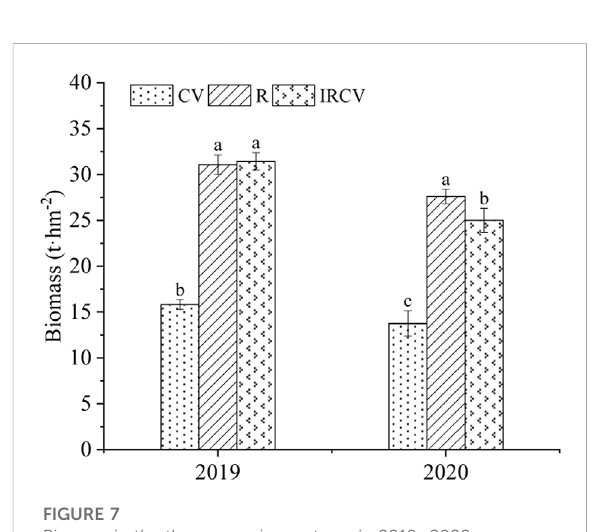
FIGURE 7 Biomass in the three cropping systems in 2019 –